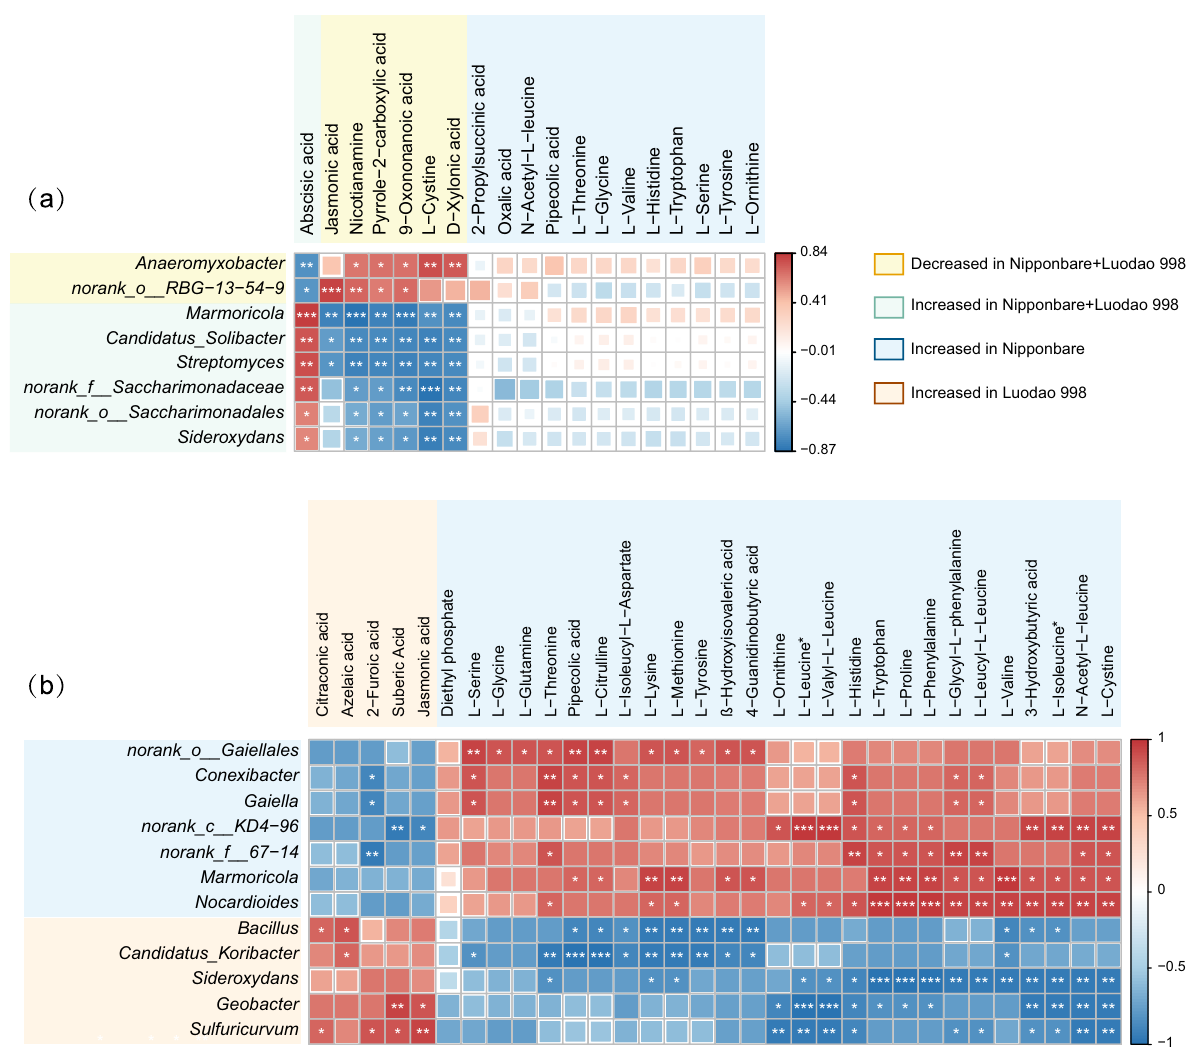
Fig. 7 Associations between rhizosphere bacterial communities and root exudates. Correlation analyses of differentially abundant genera and differential root exudates a for both rice genotypes and b under drought conditions. The abundance of genera and metabolites is visualized after log2 transformation. Asterisks indicate significant correlations (*FDR < 0.05, **FDR < 0.01 and ***FDR < 0.001; Spearman